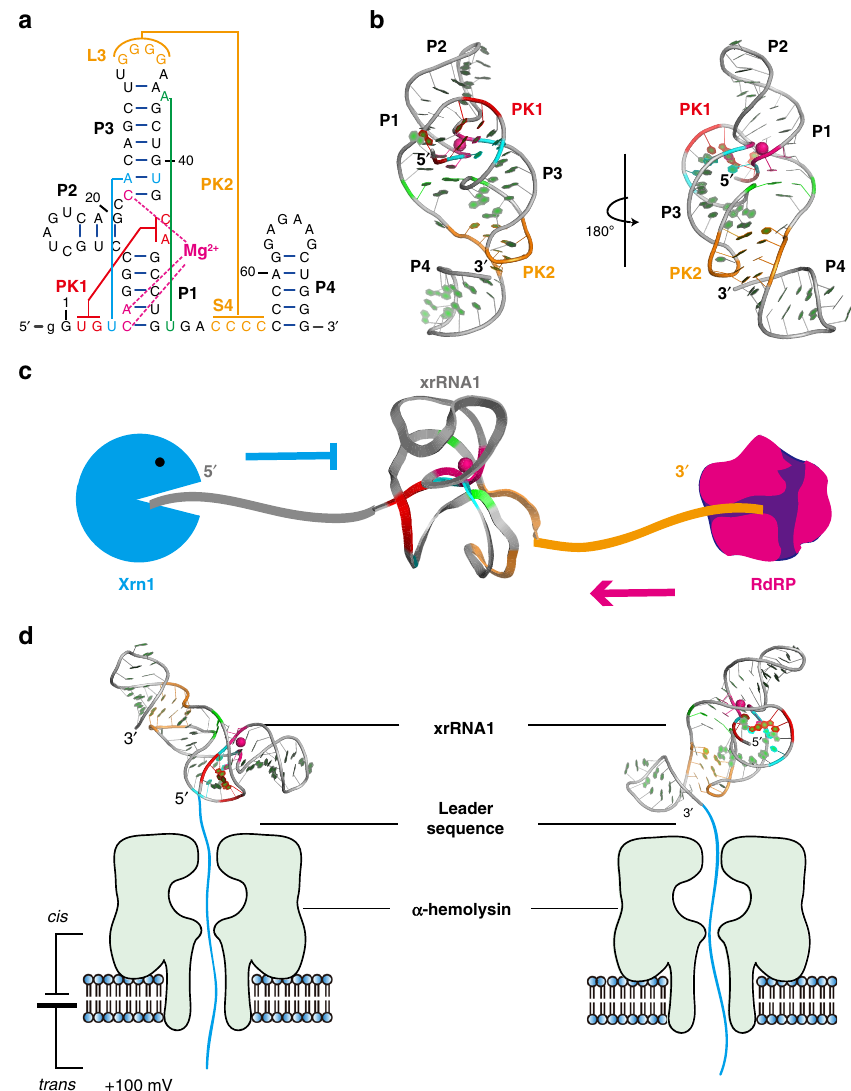
Fig. 1 Mimicking directional unfolding of ZIKV xrRNA1 in the α -HL nanopore. a , b Secondary ( a ) and tertiary structure ( b ) of ZIKV xrRNA1, which contains several tertiary interactions (cyan: U4·A23:U41 base triple, green: A36:U50 reverse pair) and two pseudoknots, PK1 (red, U2G3:C43G44) and PK2 (orange, G30-G33:C53-C56). In addition, one Mg 2 + is found to coordinate with the phosphate of C5, A6, and C22 (pink). c A cartoon shows that xrRNA1 can resist the degradation by exoribonuclease Xrn1 from 5 ′ → 3 ′ direction, yet be traversed by the viral RdRP from 3 ′ → 5 ′ direction. d Cartoons showing the directional unfolding and translocation of ZIKV xrRNA1 through the α -HL nanopore, where a 36 nt poly(rA) leader sequence was co-transcribed with xrRNA1 at the 5 ′ - or 3 ′ -end to facilitate its translocation through the